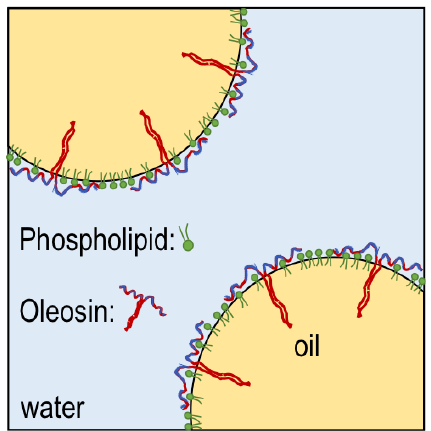
Figure 1. Illustration of oleosin proteins stabilizing oil bodies and their conformation at the interface. Oleosins are absorbed both at hydrophilic regions (purple) as well as at a central hydrophobic pin (red). Phospholipids are indicated in green. Illustration adapted from M. Rayner [21].